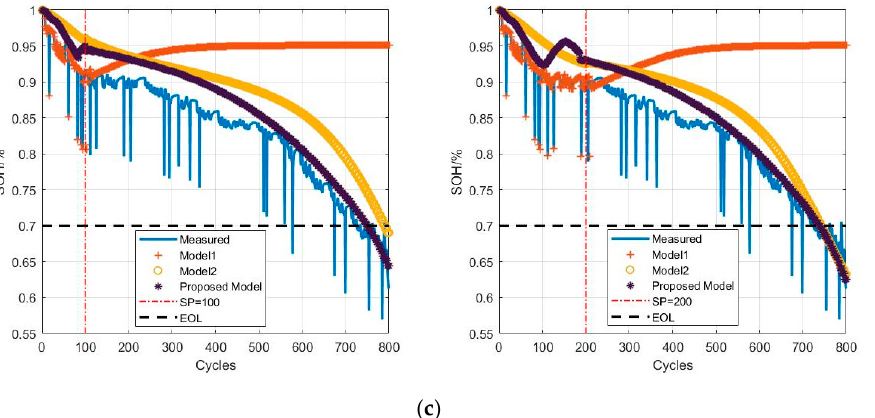
Figure 9. RUL prediction results of the proposed method for CALCE batteries under different starting points: ( a ) CS34; ( b ) CS36; ( c ) CS37. Table 1. Performance on the CALCE dataset.